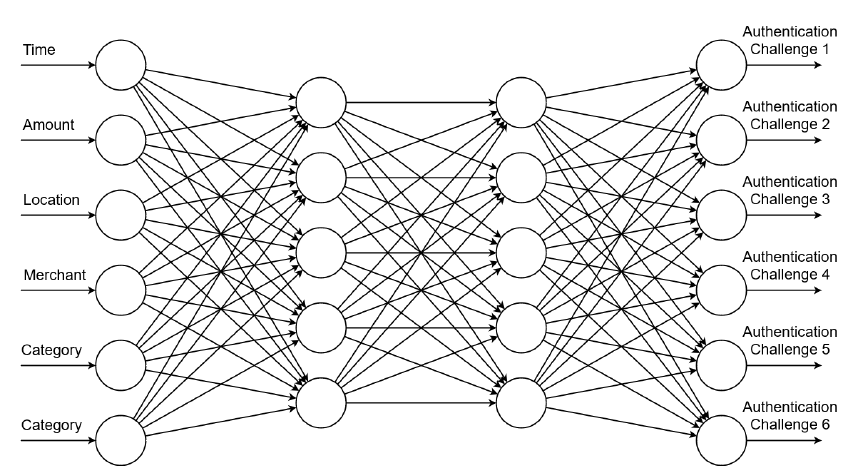
Figure 7. A feedforward neural network with many outputs.